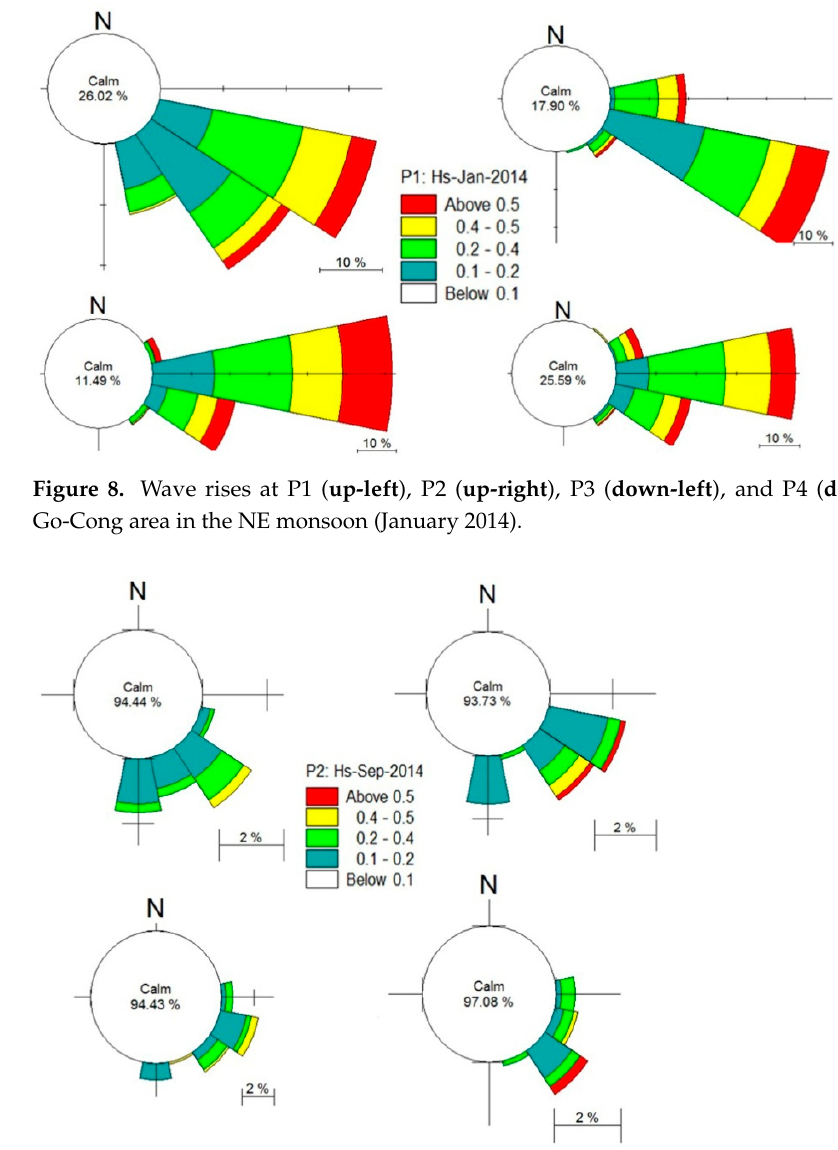
Figure 9. Wave rises at P1 ( up ‐ left ), P2 ( up ‐ right ), P3 ( down ‐ left ), and P4 ( down ‐ right ) at the Go ‐ Cong area in the SW monsoon (September 2014).